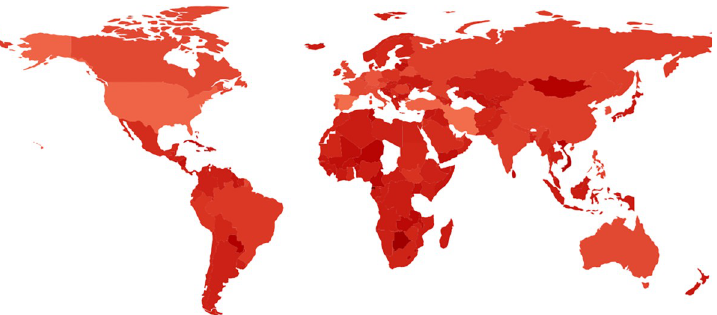
Fig 3. The exponential growth rate r in the exponential phase of COVID-19 in different countries. On one hand, Fig 2 shows the duration of the initial exponential growth of COVID-19 as computed by regime regression; on the